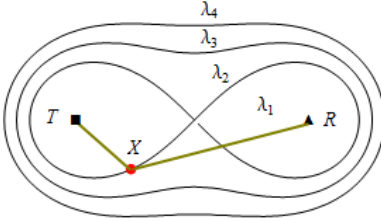
Figure 2. Sensor coverage under di ff erent SNR thresholds: λ 1 < λ 2 < λ 3 < λ 4